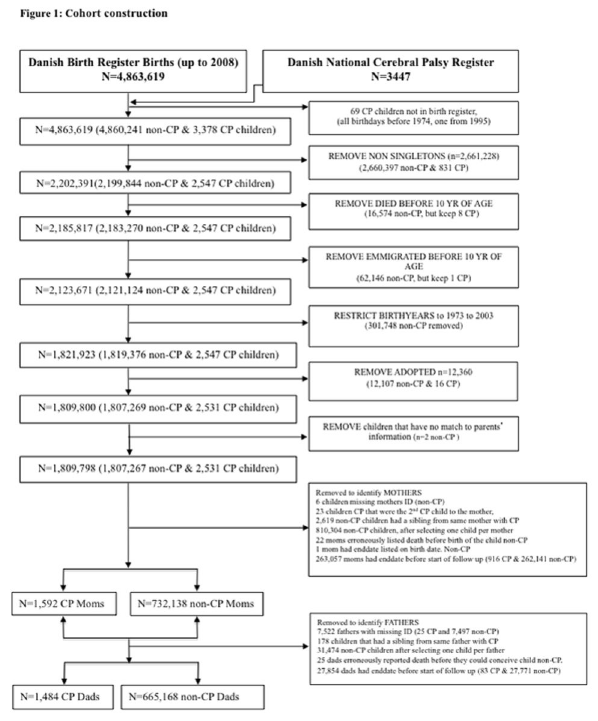
Figure 1. Algorithm of study cohort